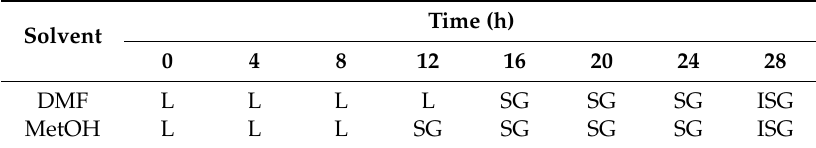
Table 2. E ff ect of time over resulting PHEMA polymerized with 75 wt % solvent at 60 ◦ C. Time (h) Solvent 0 4 8 12 16 20 24 28 DMF L L L L SG SG SG ISG MetOH L L L SG SG SG SG